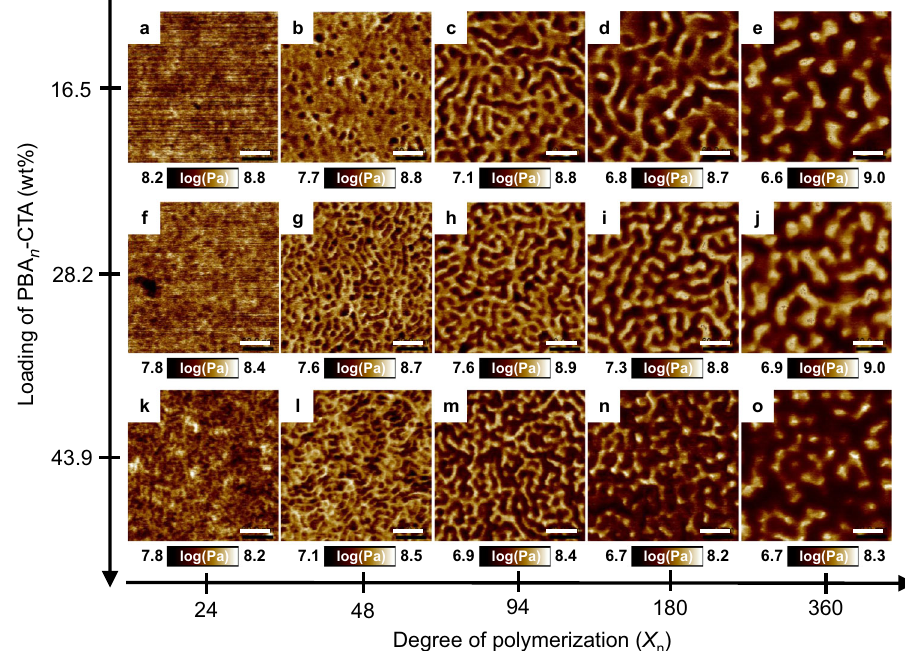
Fig. 3 Dependence of PBA-CTA degree of polymerization ( X n ) and PBA-CTA loading (wt%) on the surface morphologies of 3D printed materials. a – e 16.5 wt% PBA-CTA with PBA-CTA X n = a 24, b 48, c 94, d 180, and e 360; f – j 28.2 wt% PBA-CTA with PBA-CTA X n = f 24, g 48, h 94, i 180, and j 360; k – o 43.9 wt% PBA-CTA with PBA-CTA X n = k 24, l 48, m 94, n 180, and o 360. PBA and net -P(AA- stat -PEGDA) domains are shown in dark